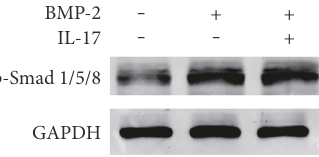
Figure 6: E ff ect of IL-17 on BMP-2-induced phosphorylation of Smad1/5/8. The rat primary osteoblasts were treated with BMP-2 (300ng/ml) in the presence or absence of IL-17 (25 ng/ml) for 48 h. The intracellular level of phosphorylated Smad1/5/8 (p-Smad1/5/8) was analyzed by Western